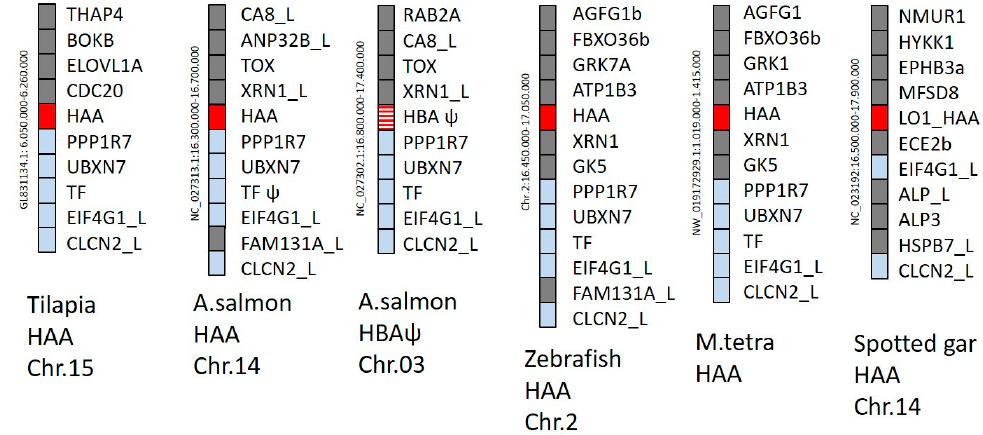
Figure 2. Genomic locations of H lineage loci in representative teleost fishes and spotted gar. H lineage genes and their flanking genes in Tilapia ( Oreochromis niloticus ), Atlantic salmon ( Salmo salar ), Zebrafish ( Danio rerio ), Mexican tetra ( Astyanax mexicanus ), and Spotted gar ( Lepisosteus oculatus ) are shown as boxes. In Atlantic salmon, the region is duplicated and found on two different chromosomes. Red boxes represent intact H lineage genes, striped red represents a probable H lineage pseudogene, and light blue shading is used for non-MHC genes present in three or more species, while grey shading represents non-MHC genes showing poorer conservation in this region. The database sequence position of the depicted genomic region is shown in small font on the left side of each region, and if known the chromosome number is shown at the bottom of the figure. The ψ symbol indicates a probable pseudogene. The H lineage loci appear not to be linked with the classical Mhc region (e.g., compare the H loci positions in Figure 2 with the positions of the classical MHC-I loci in reference [30]), which is quite common among nonclassical MHC-I (e.g., [10,30]). 3.3. Intron-Exon Organization of H Lineage Genes and Losses of Ectodomain Exons Comparison of available genomic and cDNA information (Supplementary Table S1) allowed analysis of intron-exon organization. Intron-exon organizations of representative H lineage genes are shown in Figure 3, and sequences encoded by the α 1, α 2, and α 3 exons are separately aligned in Figure 4. Spotted gar Leoc-HAA encodes all domains of a consensus MHC-I molecule, including α 1, α 2, α 3, and CP/TM/CY domains, and the intron-exon organization is as commonly found among MHC-I genes (Figure 3). In contrast, cDNA analysis indicates that teleost fish H lineage genes do not possess α 3 domain exon sequences (Figure 4 and Supplementary Text S1) and analysis of the genomic region sequences confirms this absence (Figure 3). Furthermore, in neither cDNA (Figure 4; Supplementary Text S2) nor genomic DNA (Figure 3) could an α 1 domain exon sequence be found for Mexican tetra Asme-HAA , and this α 1 absence was confirmed at the cDNA level for another characiform fish, pacu ( Piaractus mesopotamicus ) (Figure 4; Supplementary Text S1). Characiformes are related with Siluriformes and Gymnotiformes (Figure 1; [46]), and in Siluriformes, the deterioration of a consensus type MHC-I ectodomain is also pronounced. For example, in the two investigated fish of the genus Silurus , Southern catfish ( Silurus meridionalis ) and Amur catfish ( Silurus asotus ), the α 2 exon appears to be entirely lacking according to investigated cDNA sequences (Figure 4; Supplementary Text S1); however, genomic information for these Silurus H genes is absent and, theoretically, there might be additional transcripts from the same genes that do include an α 2 exon. Yet, for the related siluriform species channel catfish ( Ictalurus punctatus ), both cDNA and genomic sequence information is available (Supplementary Table S1), providing solid evidence that large parts of both α 1 and α 2 exon consensus were lost (Figure 3,4), and this probably relates to the same lack of importance of the ectodomains as reflected in the complete loss of α 1 exon sequences in characiform